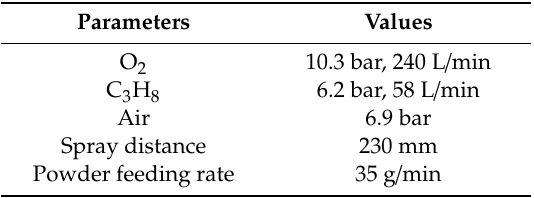
Table 2. HVOF spraying parameters of NiCrAlY